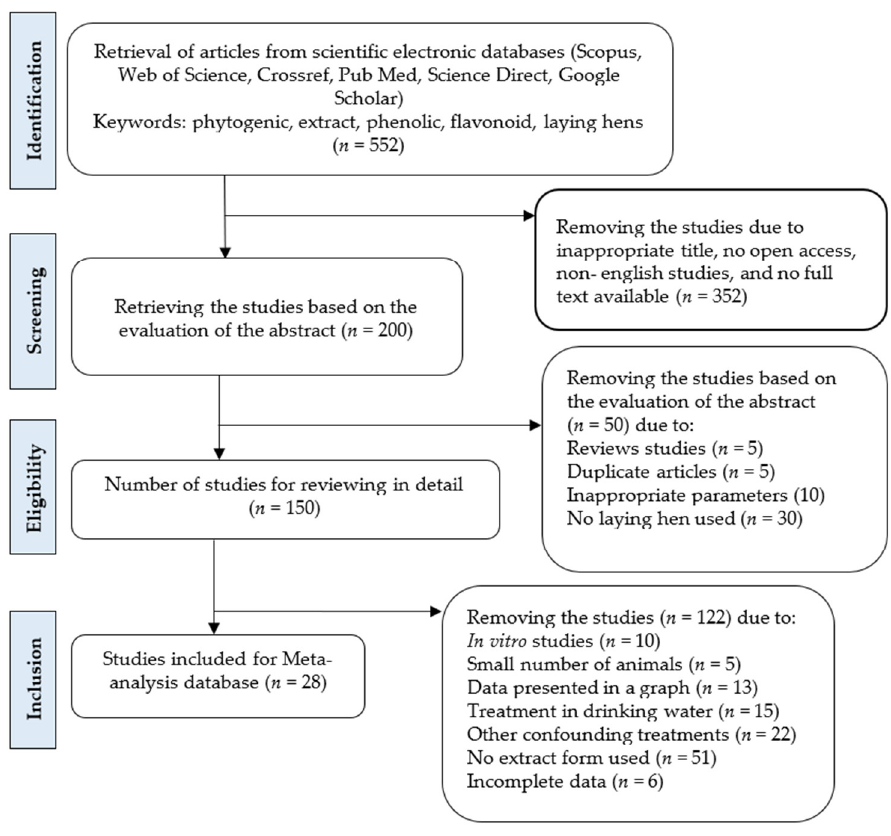
Figure 1. Flowchart of identification, screening, and inclusion process of meta-analysis database.